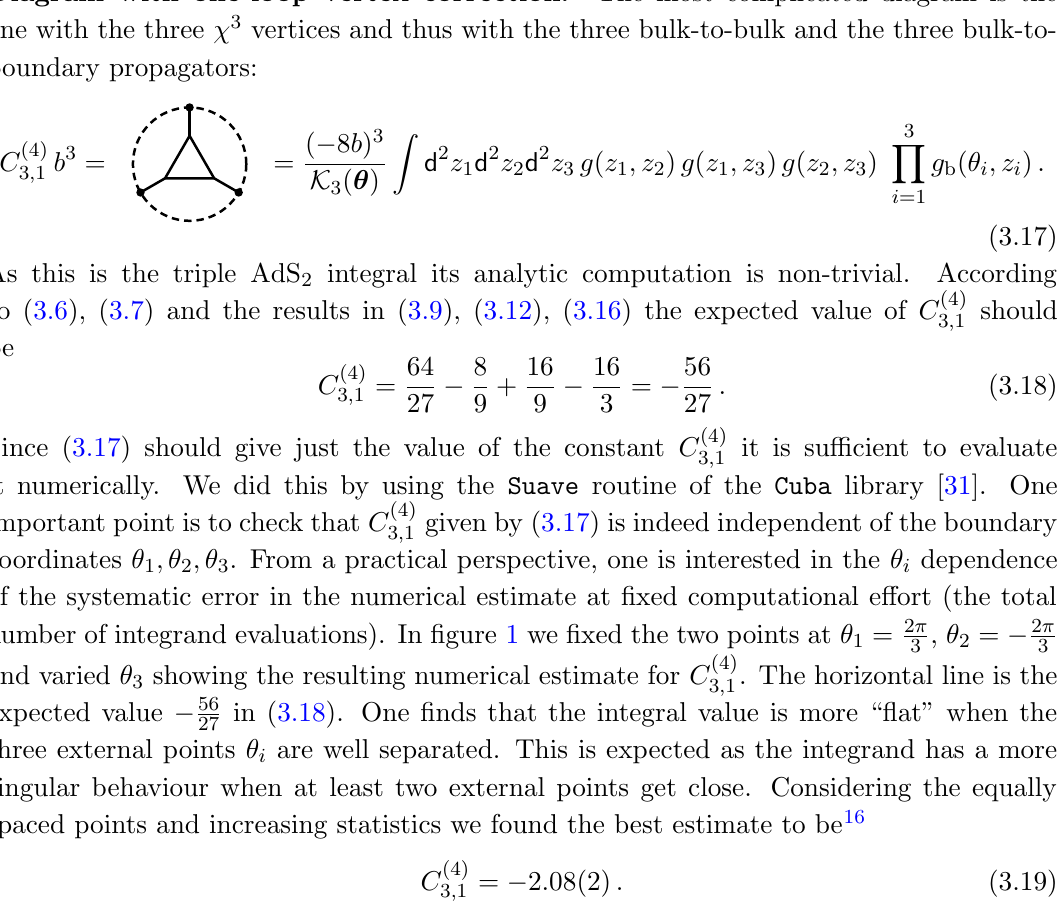
extracted by 10 7 integrand evaluations for (cid:18) 1 = 2 (cid:25) 3 ; 1 . The horizontal blue line is the expected value (cid:0) 56 3